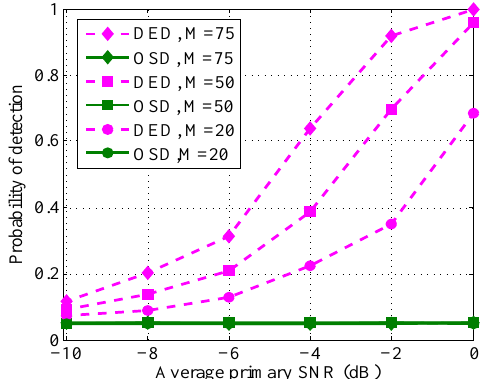
Figure 4. Probability of detection: DED and OSD vs. M for different SNRs | Constant primary signal | Weibull fading: Shape parameter = 1 , Scale parameter = 2 .